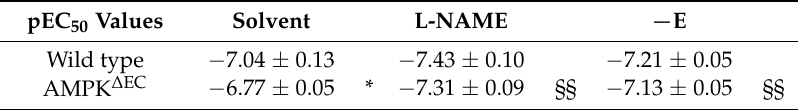
Table 1. The − log half maximal effective concentration (pEC 50 ) values relating to the consequences of endothelial-specific deletion of AMP activated protein kinase (AMPK) α 1 on vascular response to phenylephrine. Experiments were performed in endothelium intact rings the presence of solvent or N ω -nitro- L -arginine methyl ester (L-NAME; 300 µ mol/L), as well as in endothelium-denuded ( − E) samples from the same animals; n =